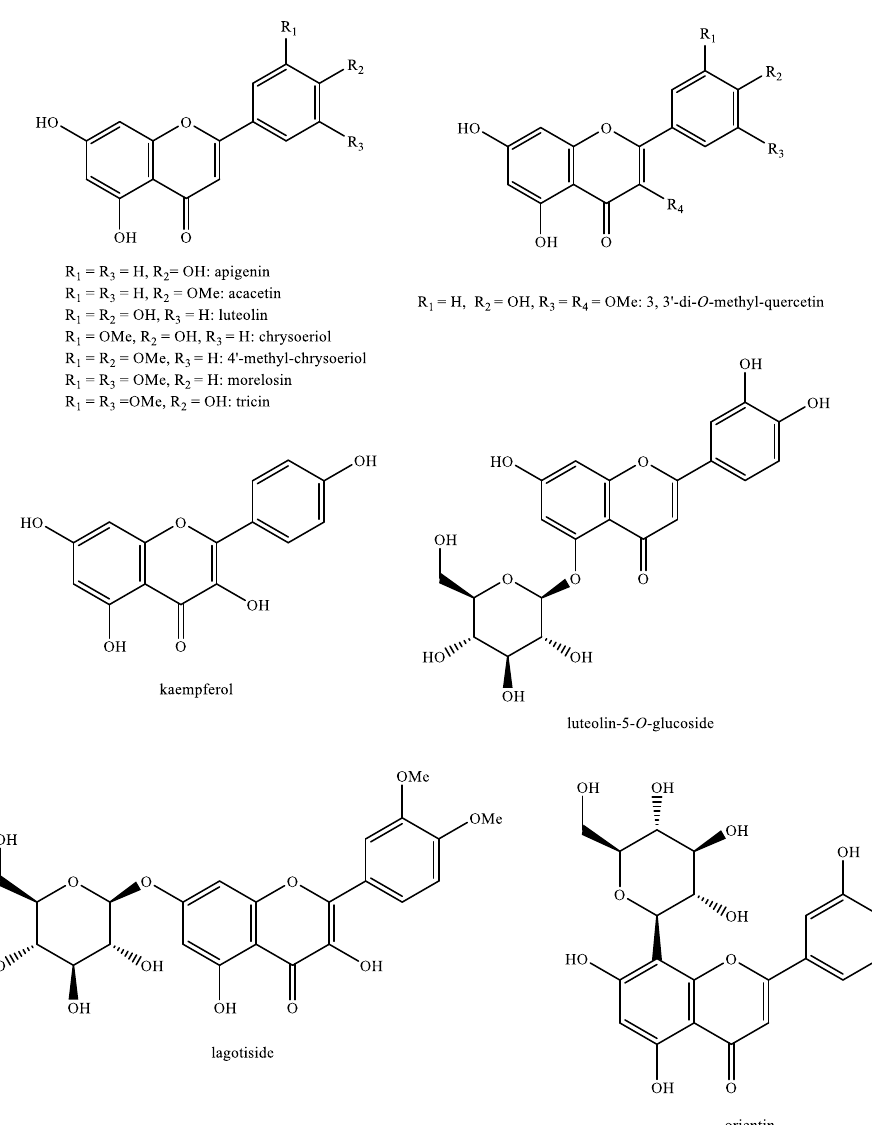
Figure 13. Flavonoids identified in Pedicularis species—part 1.